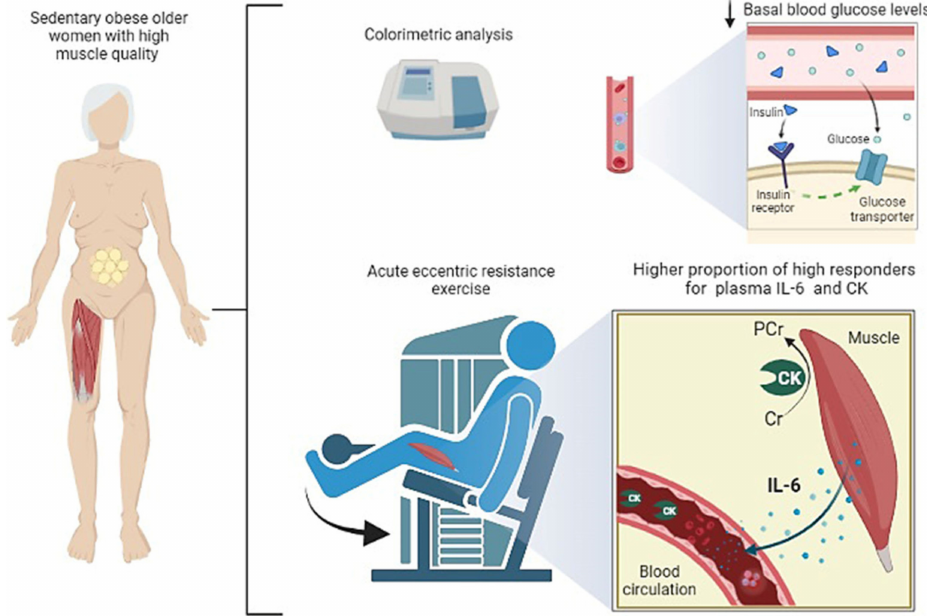
Figure 6. Overview of main findings and hypothetical mechanism involved in high MQI